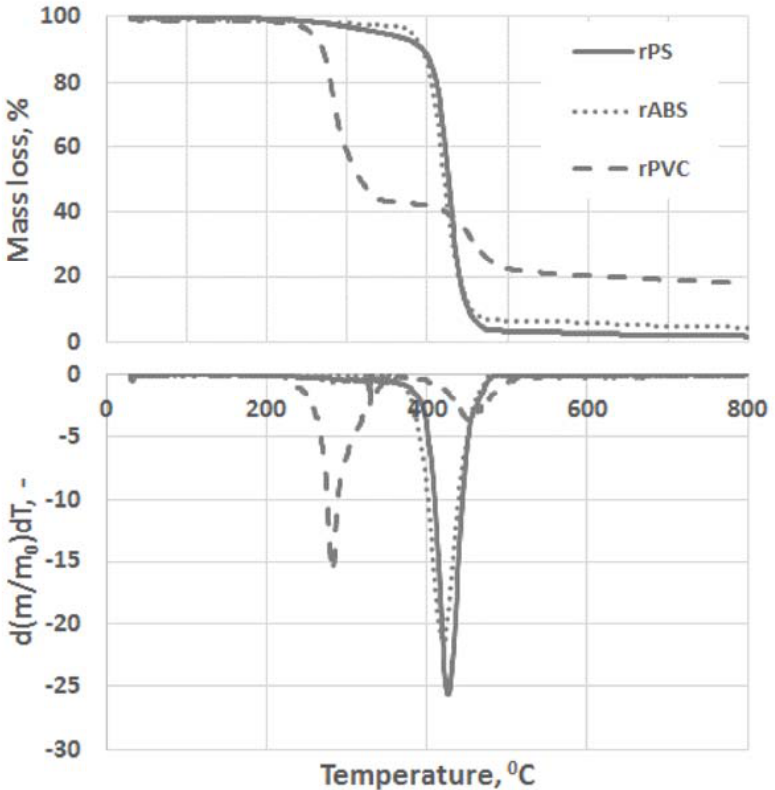
Figure 12. Thermogravimetric analysis (TGA) and differential thermogravimetry (DTG) curves of recycled Polystyrene (rPS), recycled acrylonitrile ‐ butadiene ‐ styrene (rABS) and recycled polyvinylchloride (rPVC) pyrolysis under a neutral atmosphere. Reprinted from [49] with permission of MDPI.